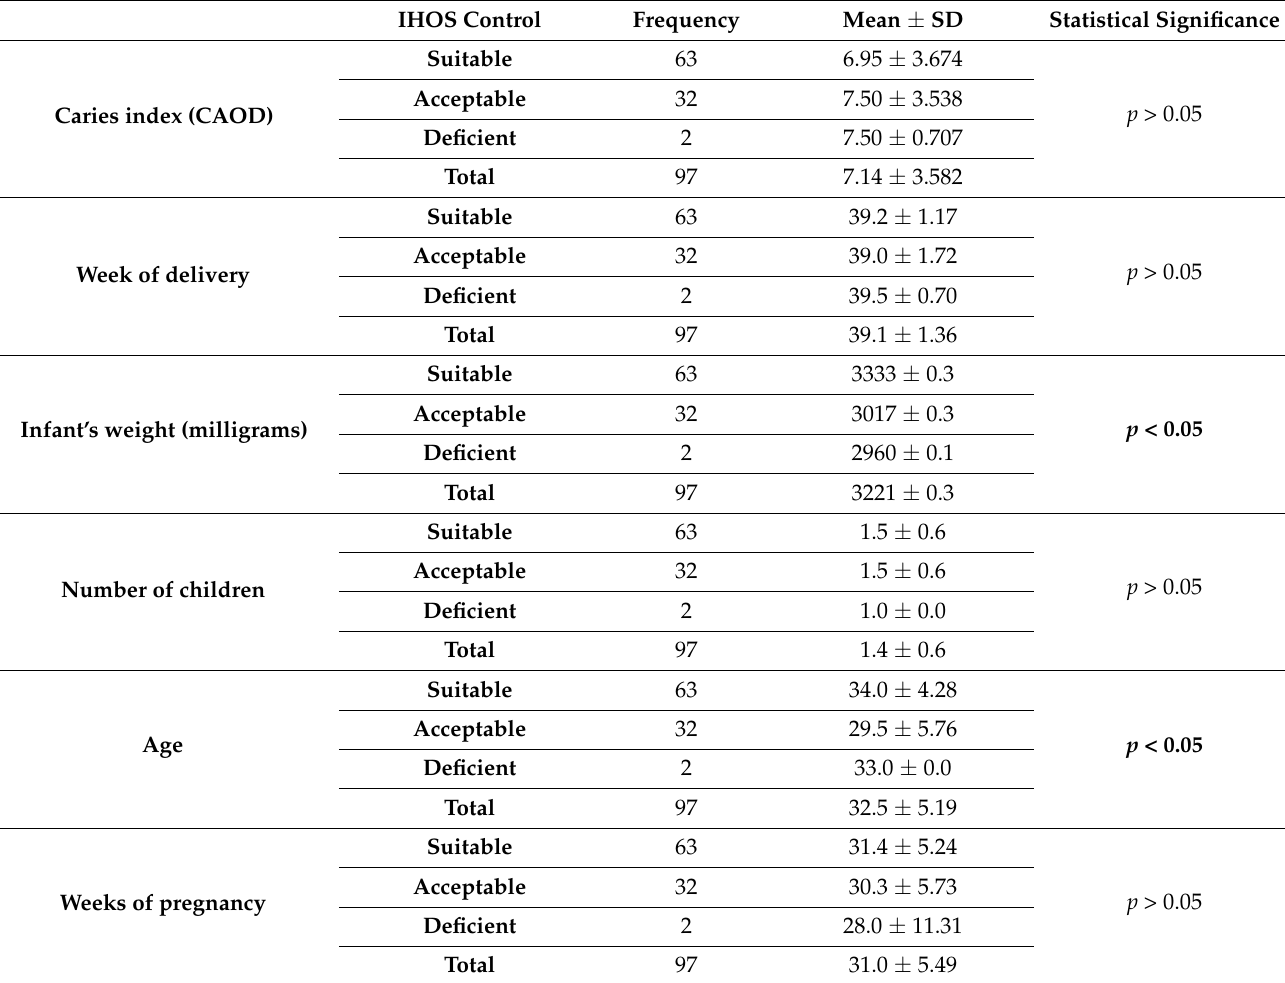
Table 3. Influence of the variables studied on the Simplified Oral Hygiene Index (IHOS).